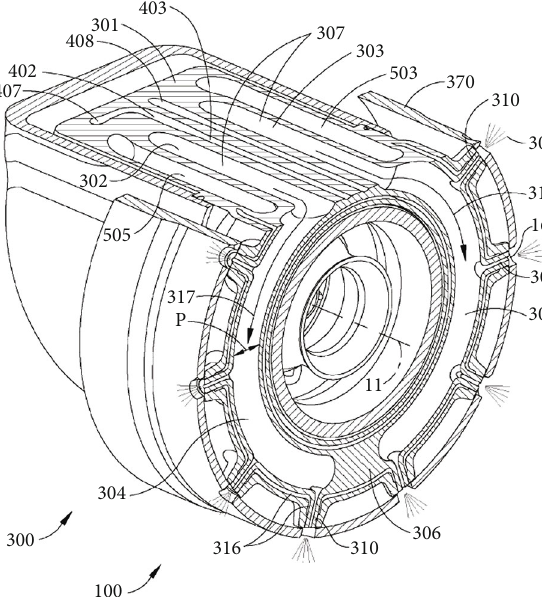
Figure 2: Fuel nozzle structure in TAPS.